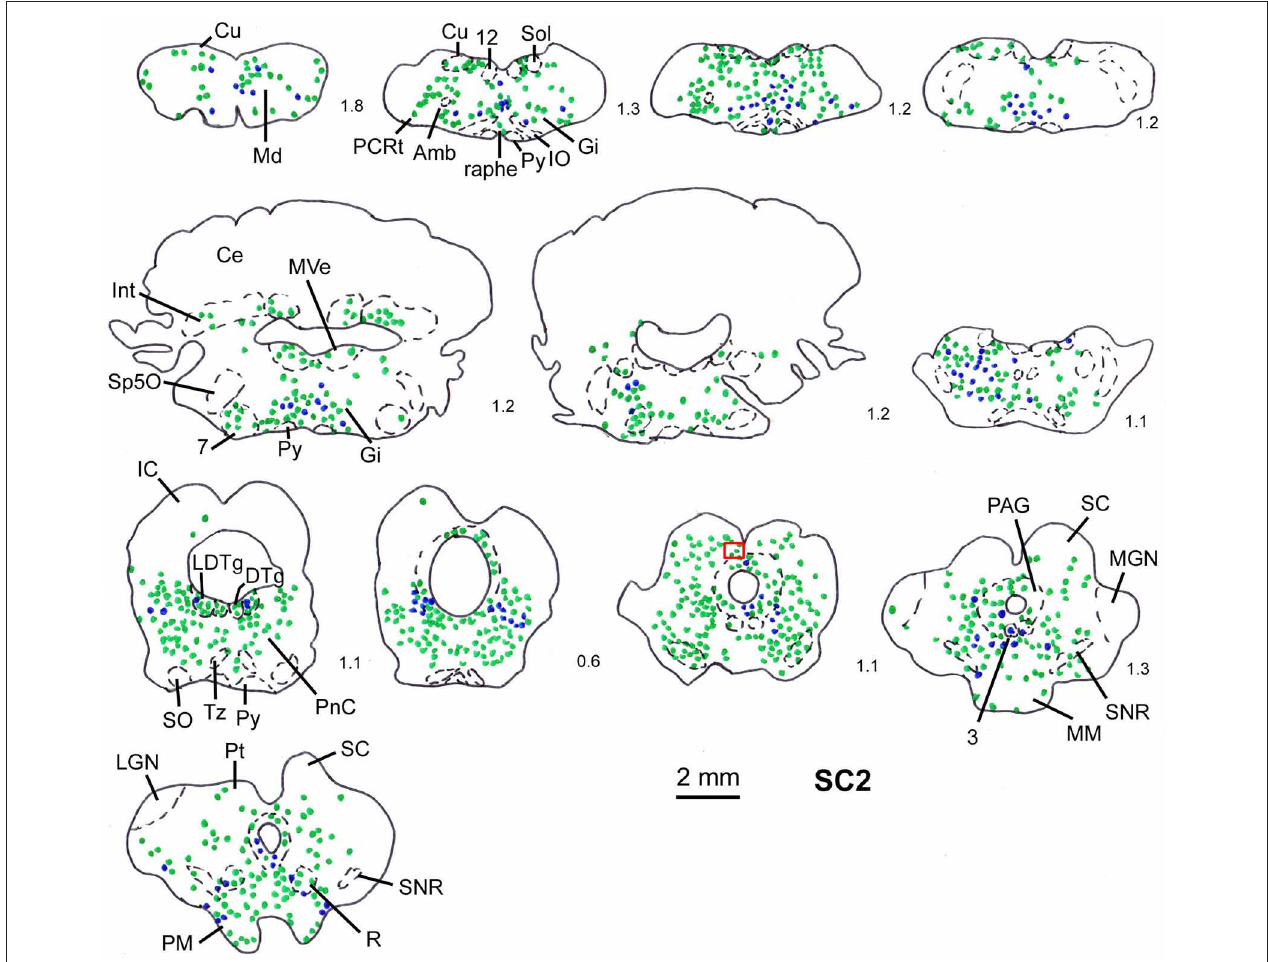
FIGURE 4 | Series of frontal sections through the brainstem and midbrain of rat SC2 demonstrating retrogradely labeled neurons after virus injection into the m. rhomboideus after a survival